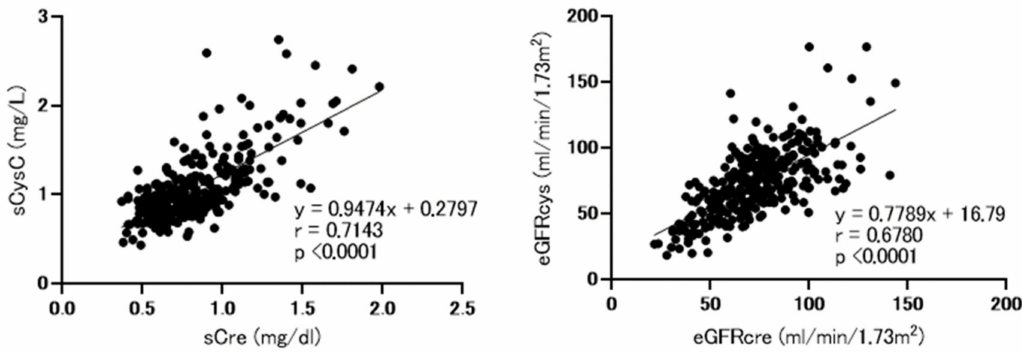
Figure 1. Correlations between baseline serum cystatin C and creatinine levels and between baseline estimated glomerular filtration rate (eGFR) based on cystatin C (eGFRcys) and creatinine (eGFRcre). sCre, serum creatinine; sCysC, serum cystatin C; eGFRcre, estimated glomerular filtration rate based on creatinine, eGFRcys; estimated glomerular filtration rate based on cystatin C. Analysis performed using spearman’s rank correlation